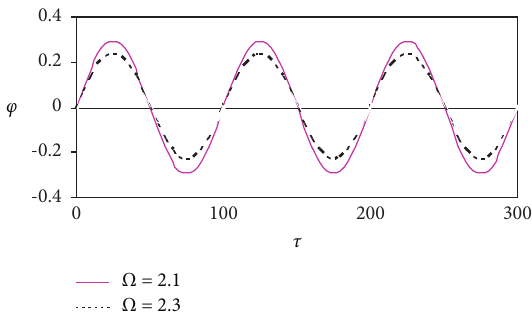
Figure 4: The numerical solutions for case (i) in Section